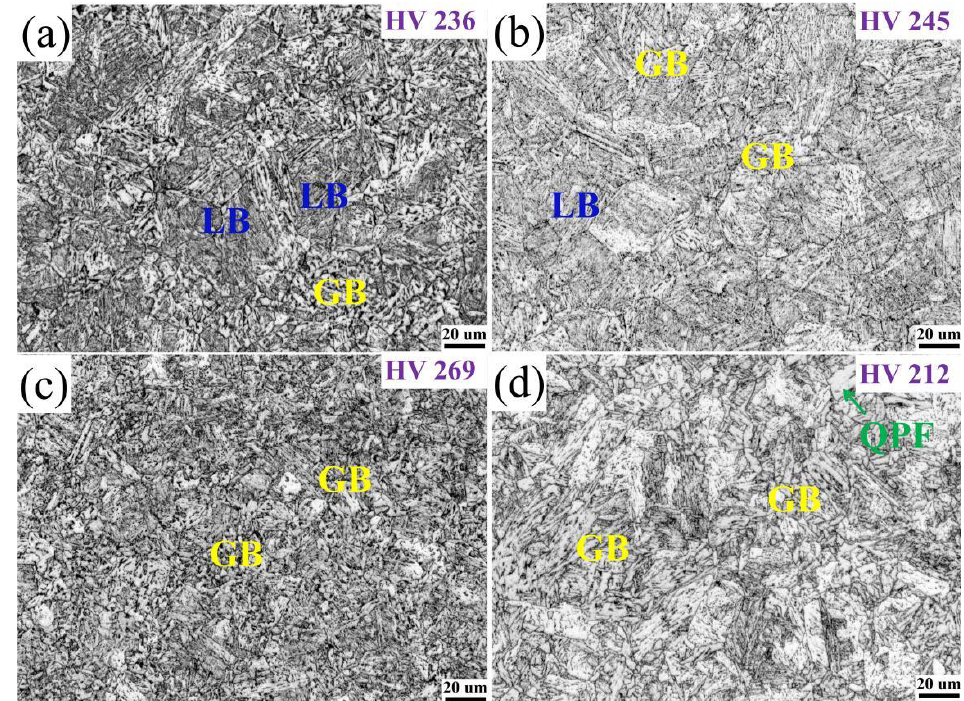
Figure 4. Optical micropraphs of heavy-wall seamless bend pipe steel after tempering at ( a ) 550 °C , ( b ) 600 °C , ( c ) 650 °C , and ( d ) 700 °C .